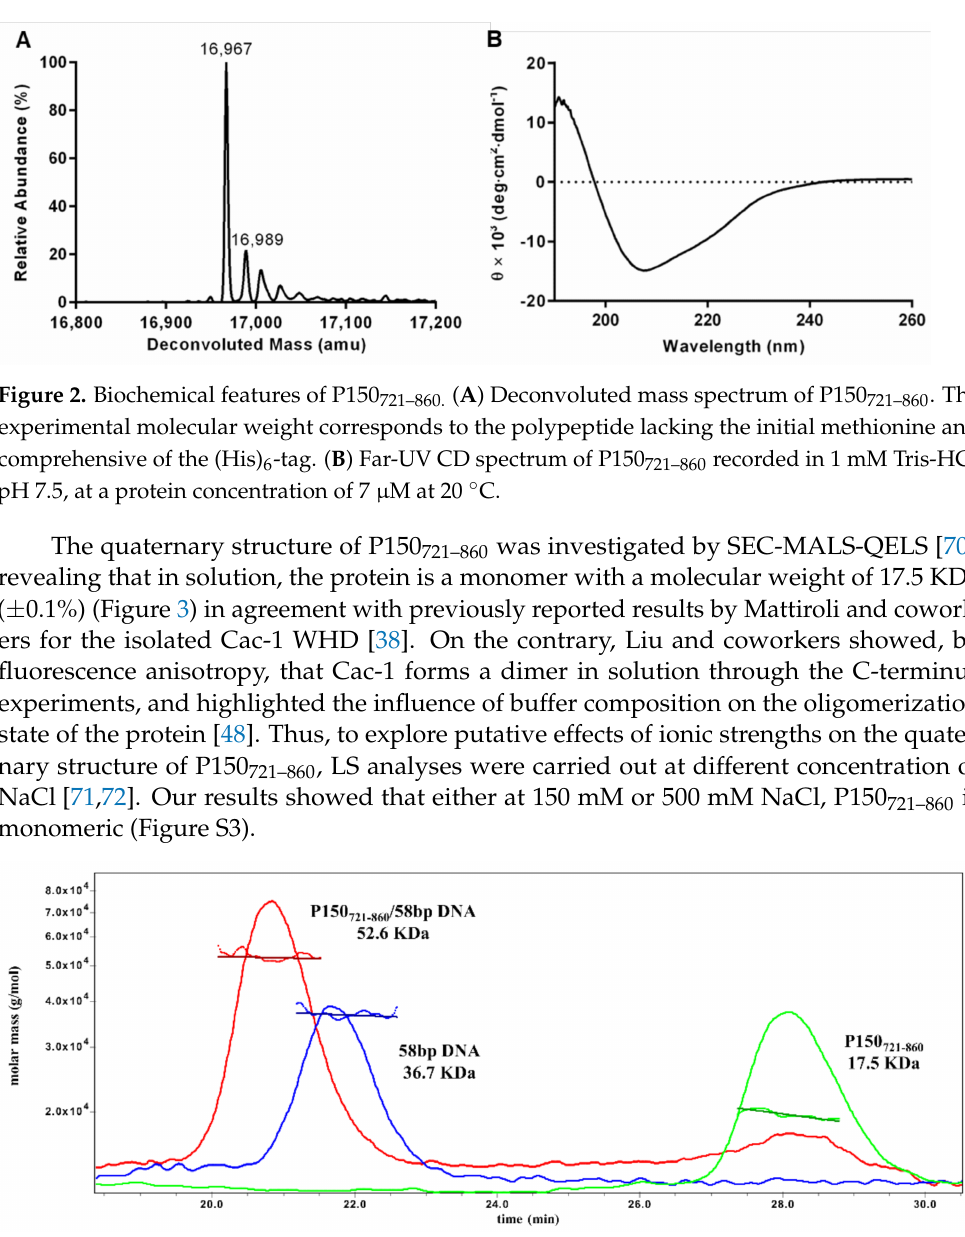
Figure 3. Molar mass of P150 721–860 , ds58 DNA, and P150 721–860 /ds58 DNA complex by SEC-MALS- QELS analysis. Overlay of light scattering chromatograms of recombinant P150 721–860 (green line), ds58 DNA (blue line), and P150 721–860 /ds58 DNA complex (red line) samples. The molar mass of each sample is reported. Runs were performed in 20 mM Tris-HCl, 150 mM NaCl, pH